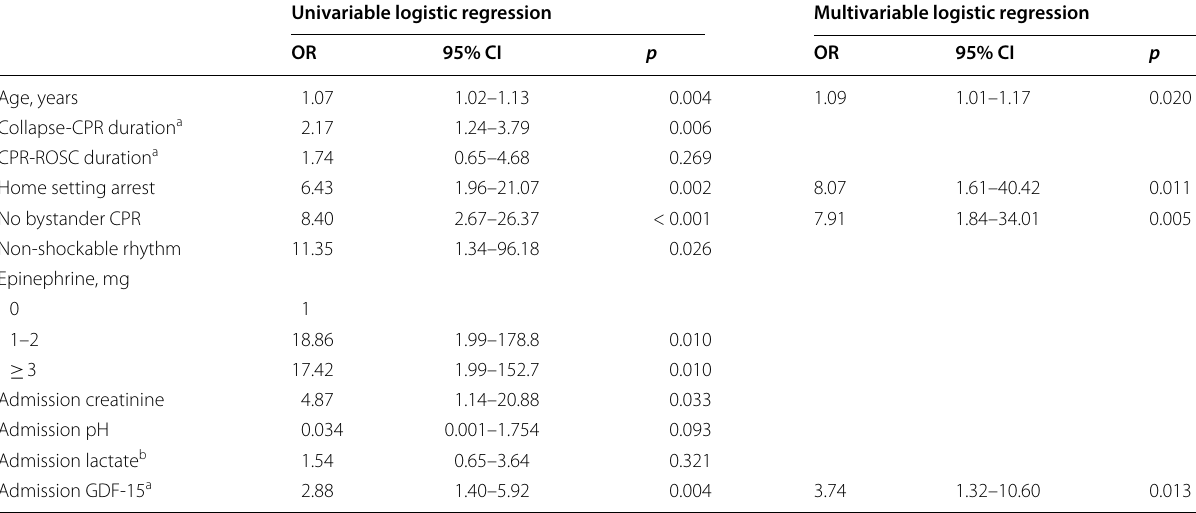
Table 2 Results of univariable and multivariable logistic regression analyses for identifying predictors of neurological outcome at 6